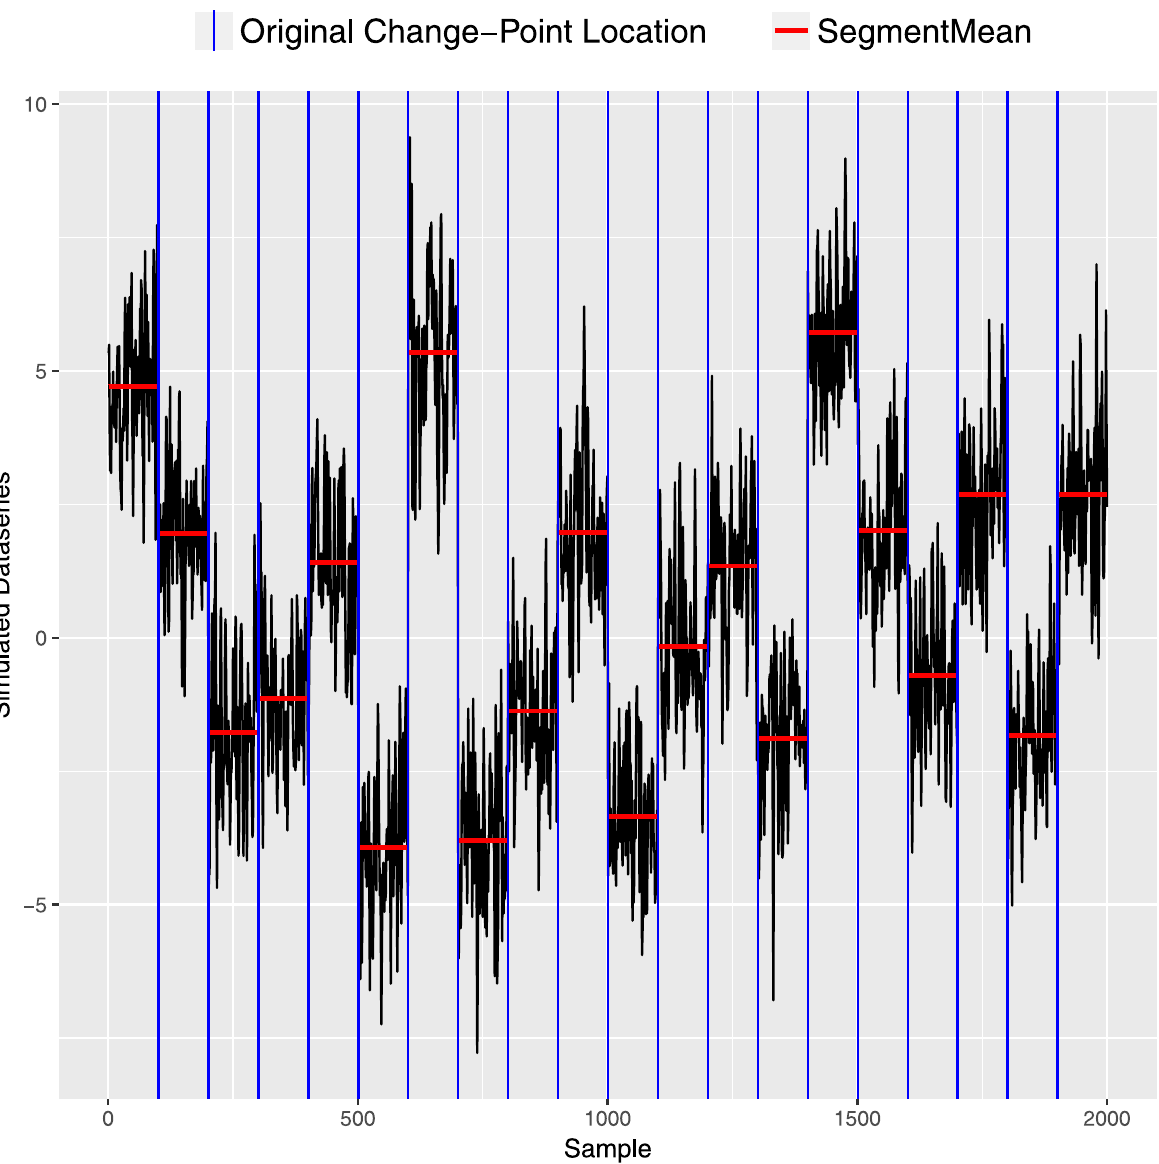
Fig 4. Simulated signal. The true change-point locations are shown as vertical blue lines and segment means are shown as horizontal red